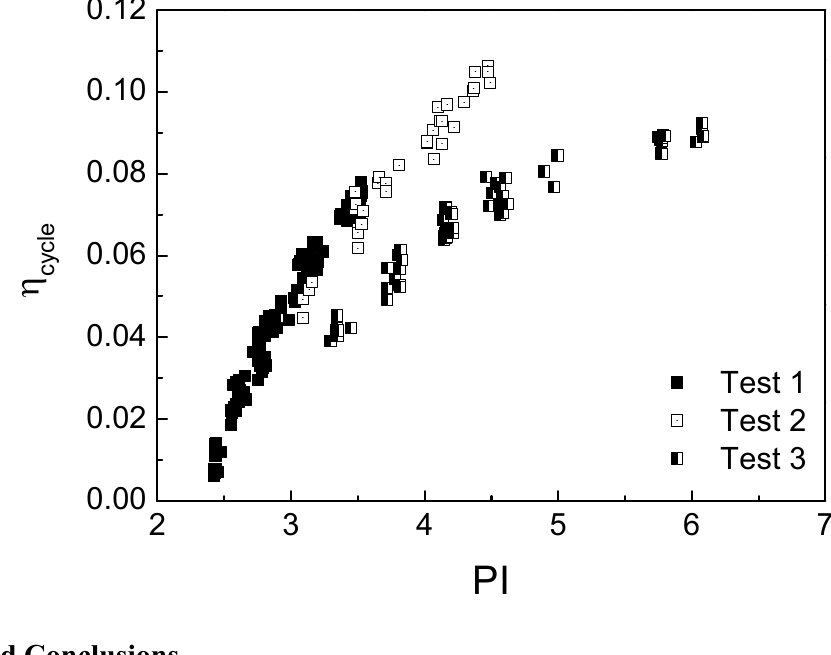
Figure 9. Effects of PI and supply pressure on cycle